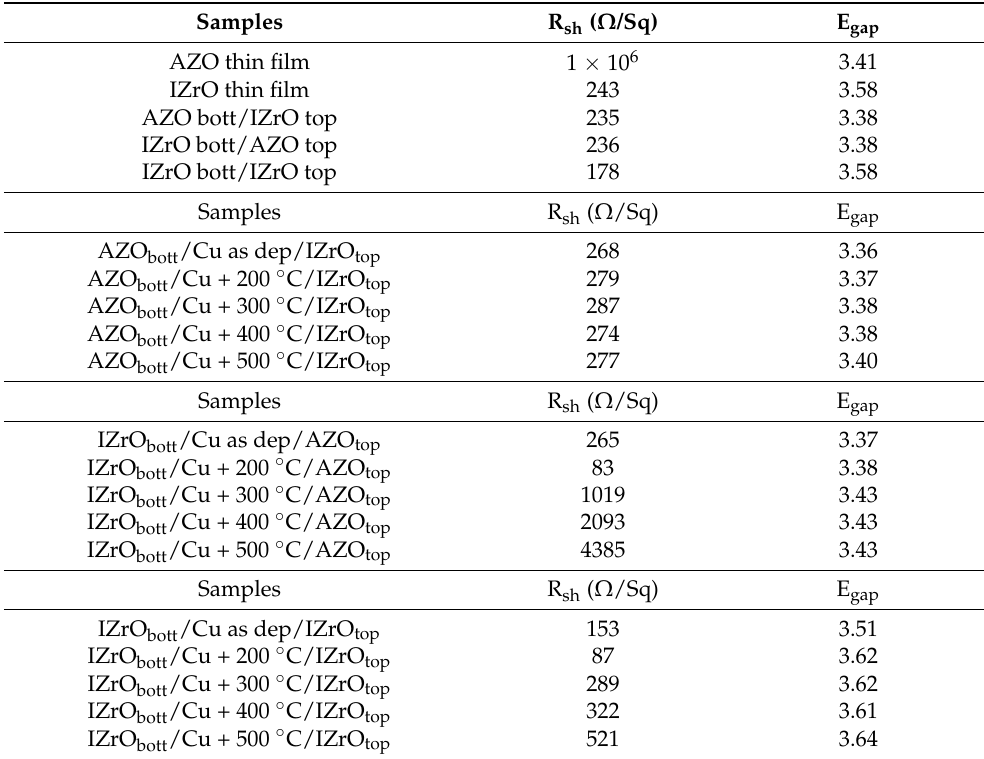
Table 1. Sheet resistances and Egap of AZO and IZrO thin film layers; AZO/IZrO, IZrO/AZO, and IZrO/IZrO double stacks; and dry systems with all combinations of AZO and IZrO layers as the top and bottom